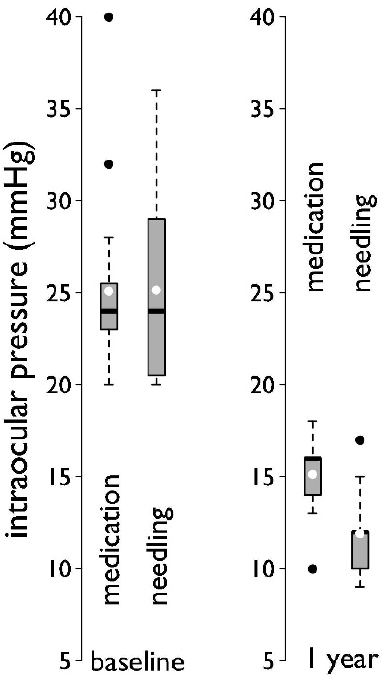
Figure 3 - Boxplot showing a comparison of IOP profiles before and after randomization at the